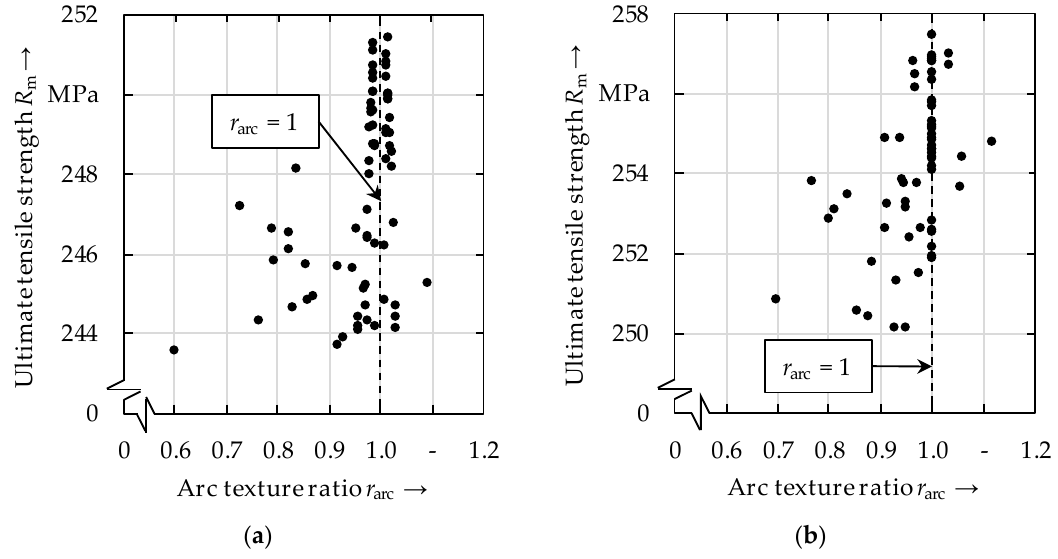
Figure 7. Ultimate tensile strength R m as a function of the arc texture ratio r arc ( a ) at a welding speed v s of 1000 mm/min and ( b ) at a welding speed v s of 1500 mm/min.